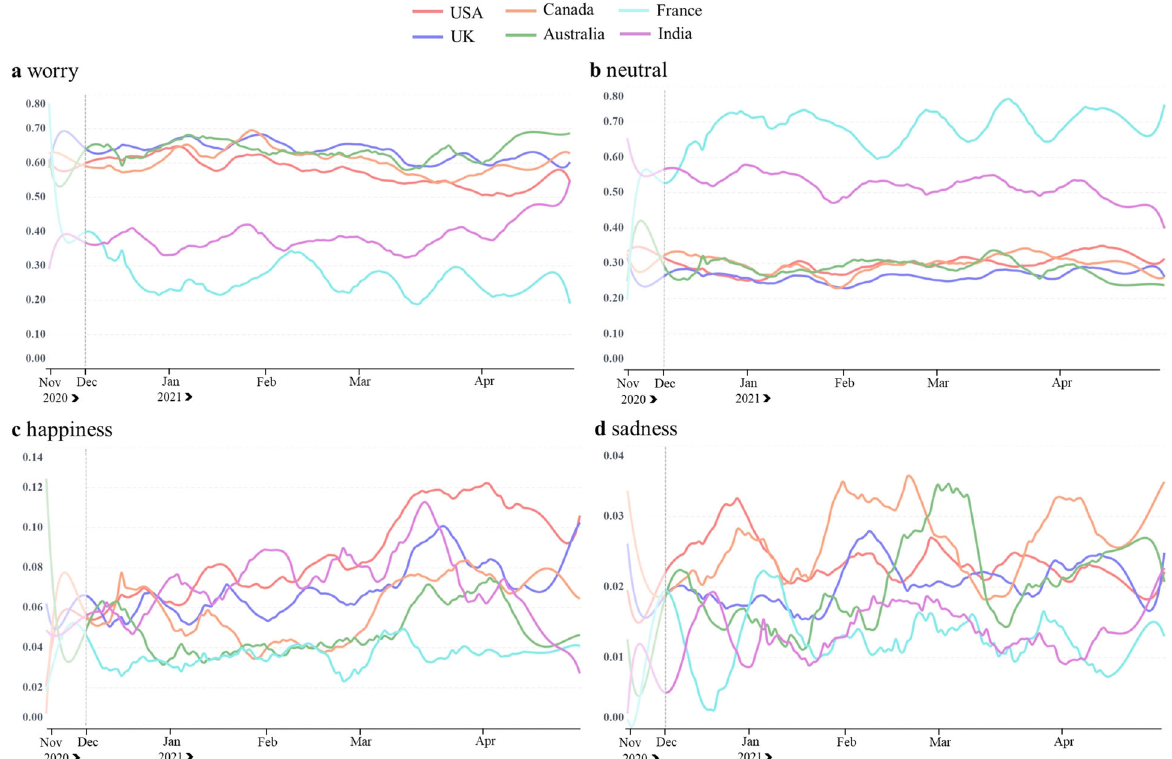
Fig. 3 Collective emotions towards vaccines in six typical countries. a – d The lines denote the different emotions of the countries in Phase I and Phase II. We divided Phase I and Phase II based on the sampling frequency, which was changed from once every 5 days to 3 times a day for self-veri fi cation, using dashed lines and transparency to distinguish. All curves are smoothed by Savitzky – Golay fi ltering to reconcile the differences in regional time zones. The results indicate that a higher sampling frequency in Phase II could articulate the nature of the public ’ s emotional fl uctuations. Worry and neutral emotions generally dominate people ’ s expressions on Twitter, which is consistent with social sentiments (Hou et al., 2021) (see the